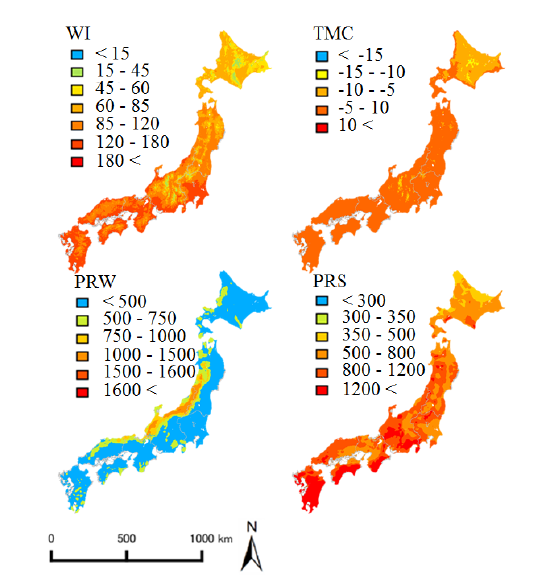
Figure 5. Distribution of future climatic variables for low- emissions scenario.